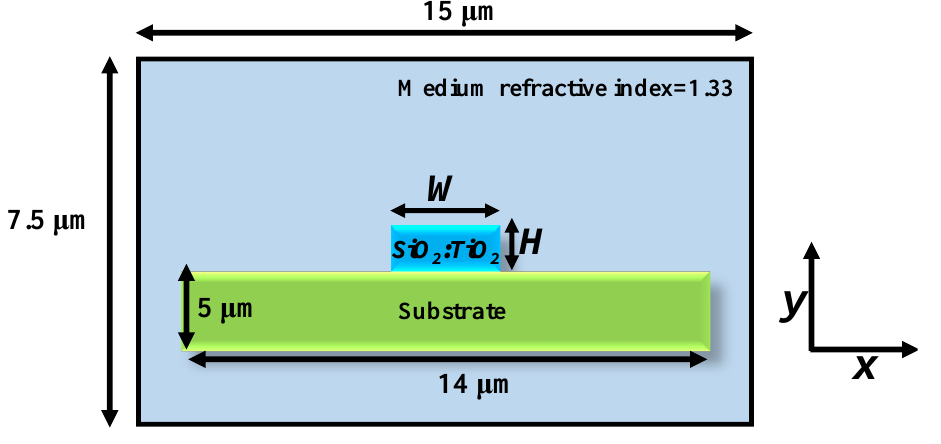
Figure 6. SiO 2 :TiO 2 ridge WG scheme.